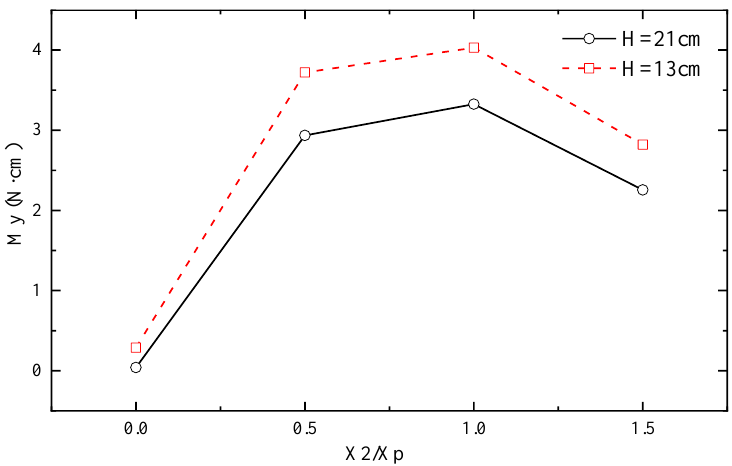
Figure 18. The lateral moment of child UAV in rotor-outside transition area.